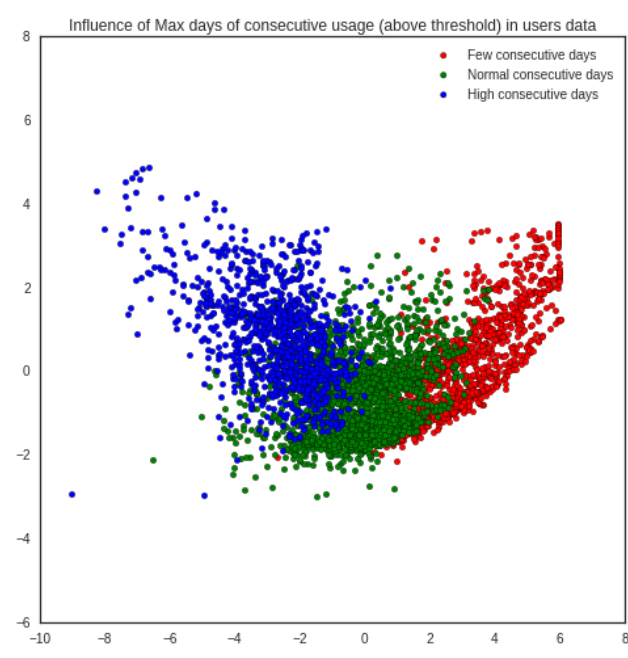
Figure 6. CPAP usage dataset projected on best 2 PCA-